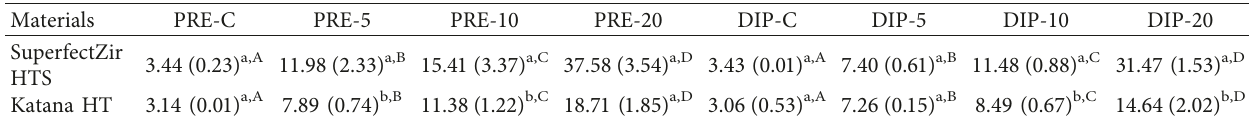
(%) for each group. m